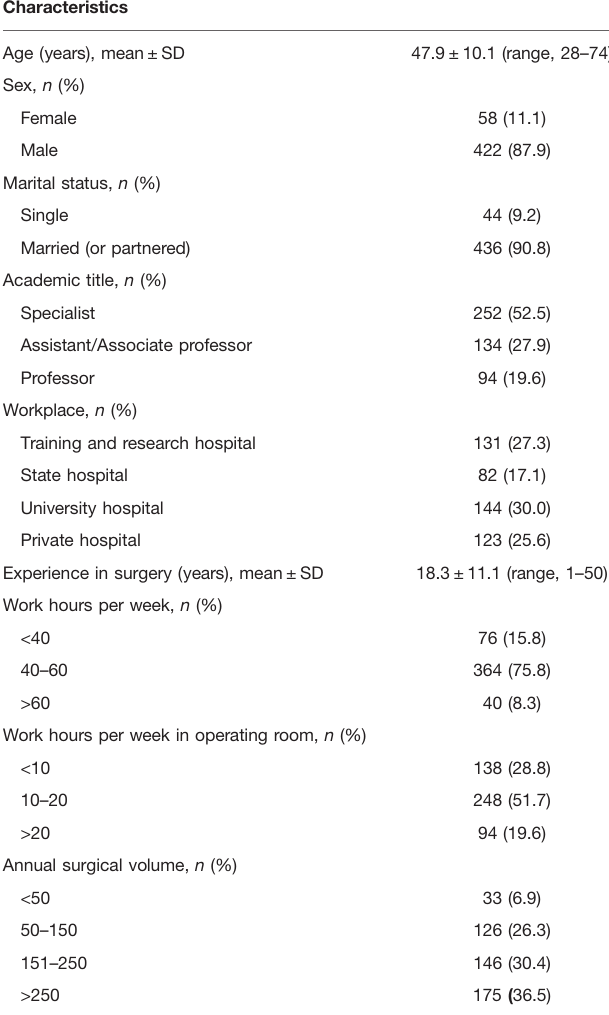
TABLE 1 | Sociodemographic and professional characteristics of the general surgeons.